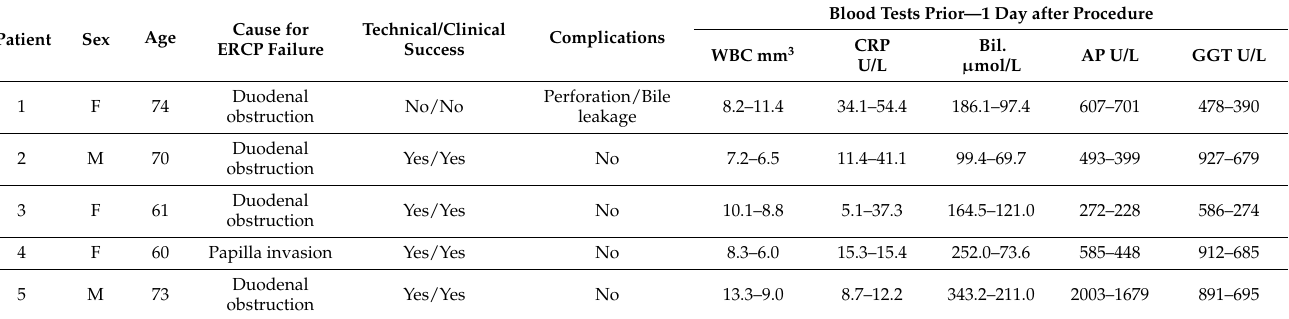
Table 2. Patients’